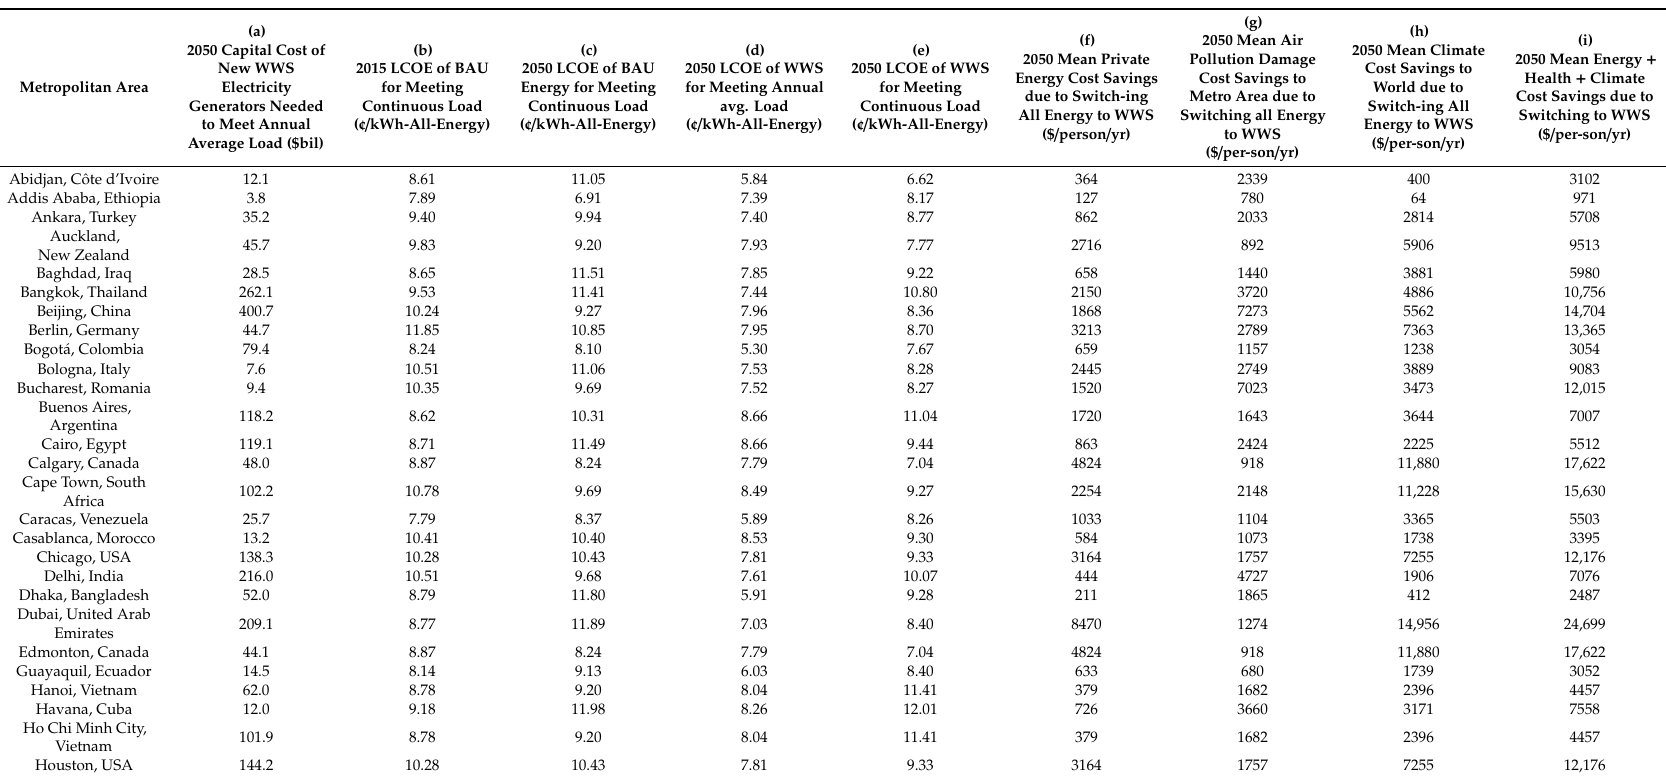
Table 7. ( a ) Mean year 2050 capital cost estimate for new generators to meet annual average WWS electric power demand after electrification of all energy sectors (this does not include the additional generators beyond those needed for annual average power in Table 2). ( b ) Mean values of the private levelized cost of energy (LCOE) for conventional fuels (BAU) in the electricity sector in 2015, which is assumed to be the LCOE for all BAU energy. LCOE estimates do not include externality costs and are assumed to account for meeting continuous load (thus accounting for grid stability). ( c ) Same as ( b ), but for 2050. ( d ) Same as ( b ), but for WWS averaged over all energy sectors in 2050 and for generators to meet annual average load. ( e ) Same as ( b ) but for WWS averaged over all energy sectors in 2050 and for generators, storage, transmission / distribution, and demand response to meet continuous load (thus accounting for grid stability). ( f ) Mean private energy cost savings per person per year due to switching from BAU to WWS in all energy sectors in 2050. ( g ) Mean estimates by metropolitan area of 2050 air pollution health and non-health cost savings per person per year due to switching to WWS. ( h ) Mean estimates of climate cost savings to the world per person per year due to switching to WWS. ( i ) Mean estimates of private energy plus health plus climate cost savings per person per year in the metropolitan area due to switching to 100% WWS. All costs are in 2013